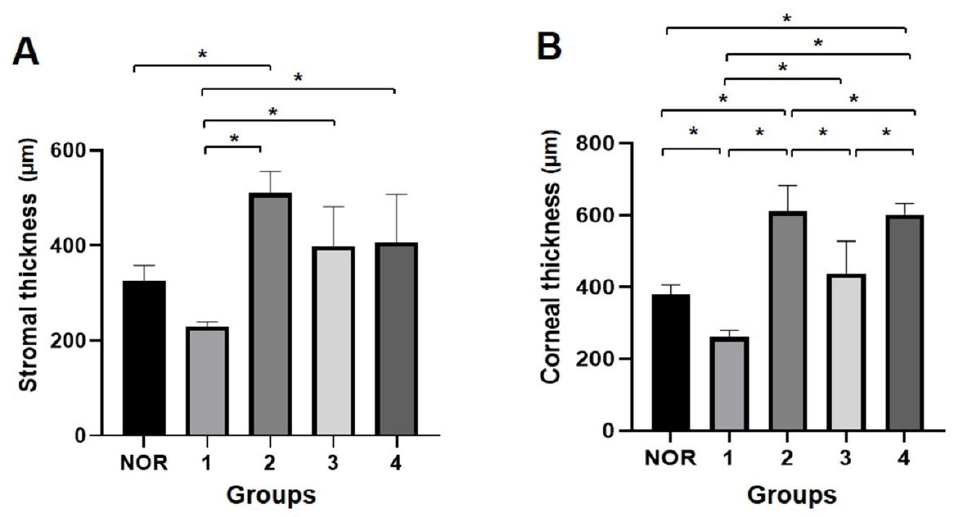
Figure 10. Thickness of total cornea and the stromal layer of each group were measured using OCT ( A , B ). The thickness of group 1 was thinner than that of normal cornea, and group 2 was the thickest. Groups 3 and 4 also showed a thicker cornea compared to group 1. n = 4 in NOR, group 1, 2, and 3; and n = 3 in group 4. *, p ≤ 0.05.